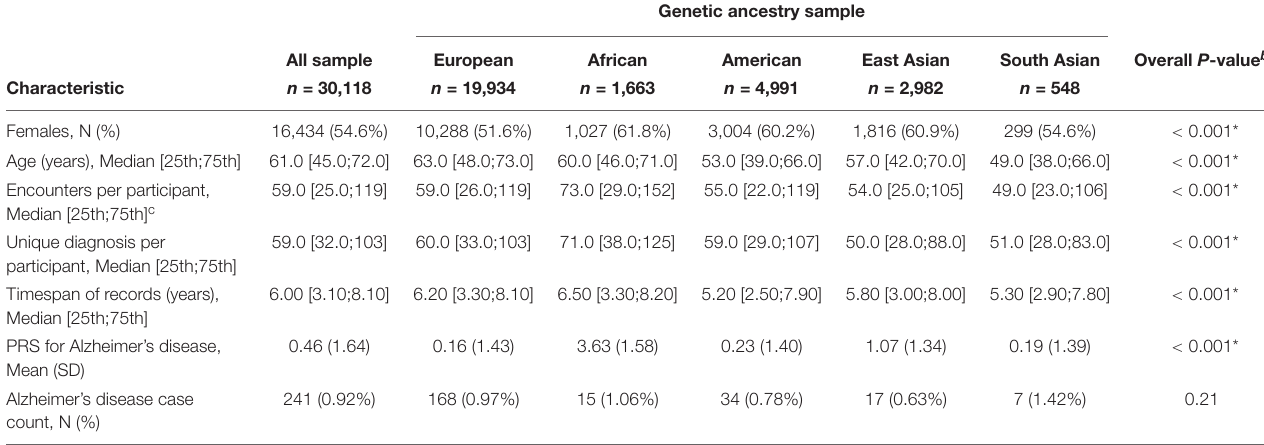
Genetic ancestry sample